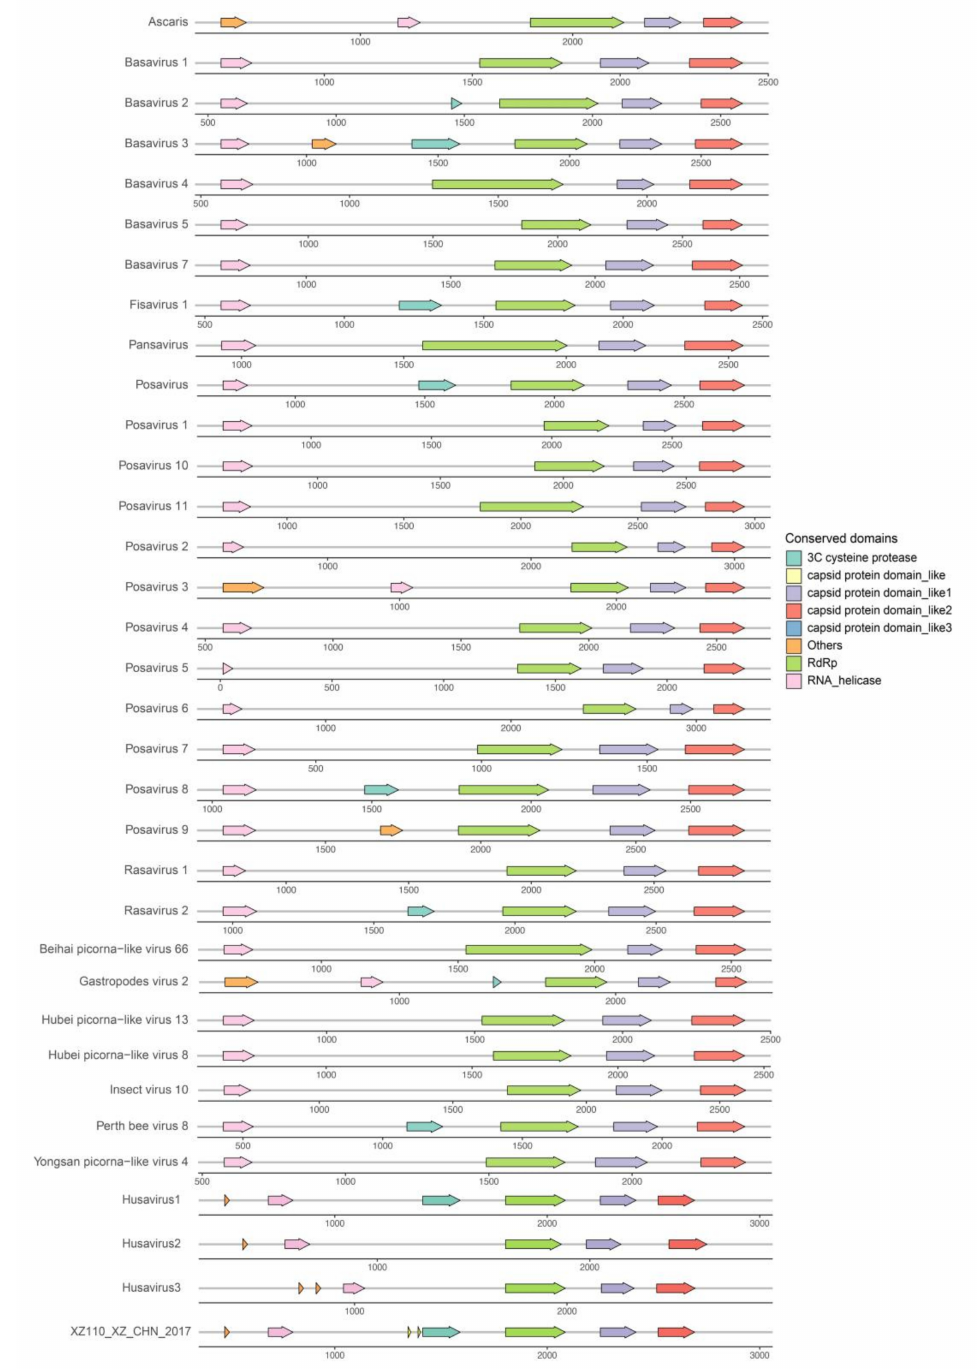
Figure 3. The genomic organization of the representative posa-like viruses and a representative husavirus identified in the present study. The arrow blocks show the conserved protein domains and their positions along the genome. Di ff erent colors indicate di ff erent protein domains. All conserved domains are drawn to scale with the genome size. For clear display, the label “others” refers to the non-conserved domains, including the Picornavirus core protein 2A, Peptidase_C3G superfamily, Poliovirus 3A protein like domain, and CRPV capsid protein-like